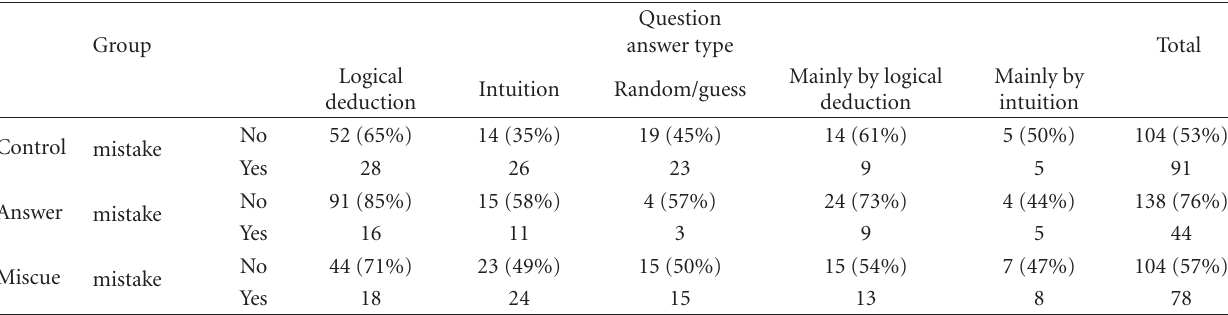
Table 5: Mistake ∗ question answer type ∗ group Cross-tabulation